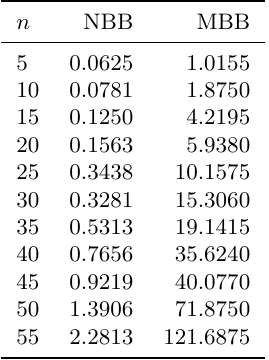
Table 1: Total solution times in seconds for 100 randomly generated instances of the problem for each reported value of n . The following abbreviations are used: NBB = normal branch and bound technique with piecewise linear enveloping and MBB = mixed 0/1 branch and bound